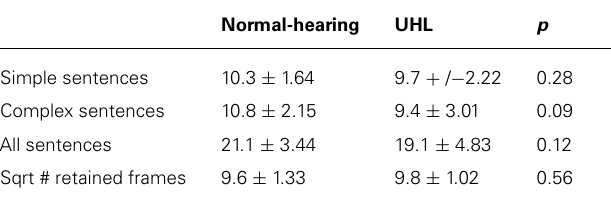
Table 3 | In-scanner task performance for simple sentences (13 trials), complex sentences (13 trials), and all sentences (26 trials); and square root of the # of retained frames; for the normal-hearing children in the study and the children with unilateral hearing loss (mean ± std).